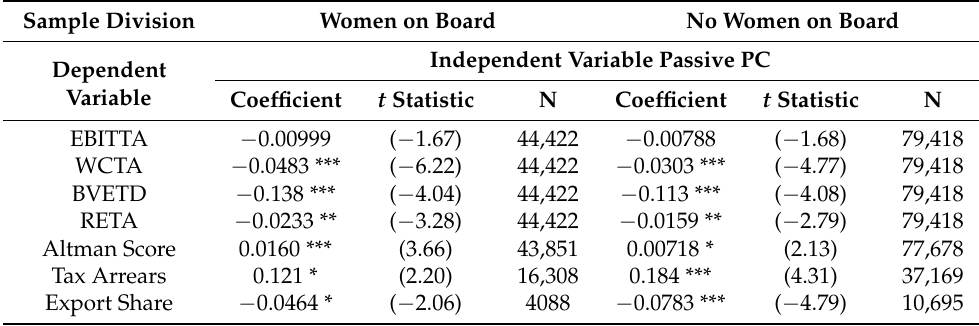
Table 4. Coefficients, p -values, and t statistics in the sub-populations of boards with women and boards with no